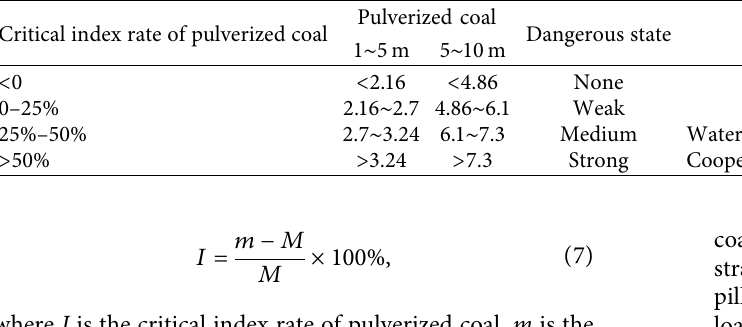
Figure 15: In situ case of synergistic effect: (a) anchor net support; (b) after the high-pressure water jet roadway gang decompression on the basis of cooperative support. Table 7: Prediction and prevention method of limit value of coal